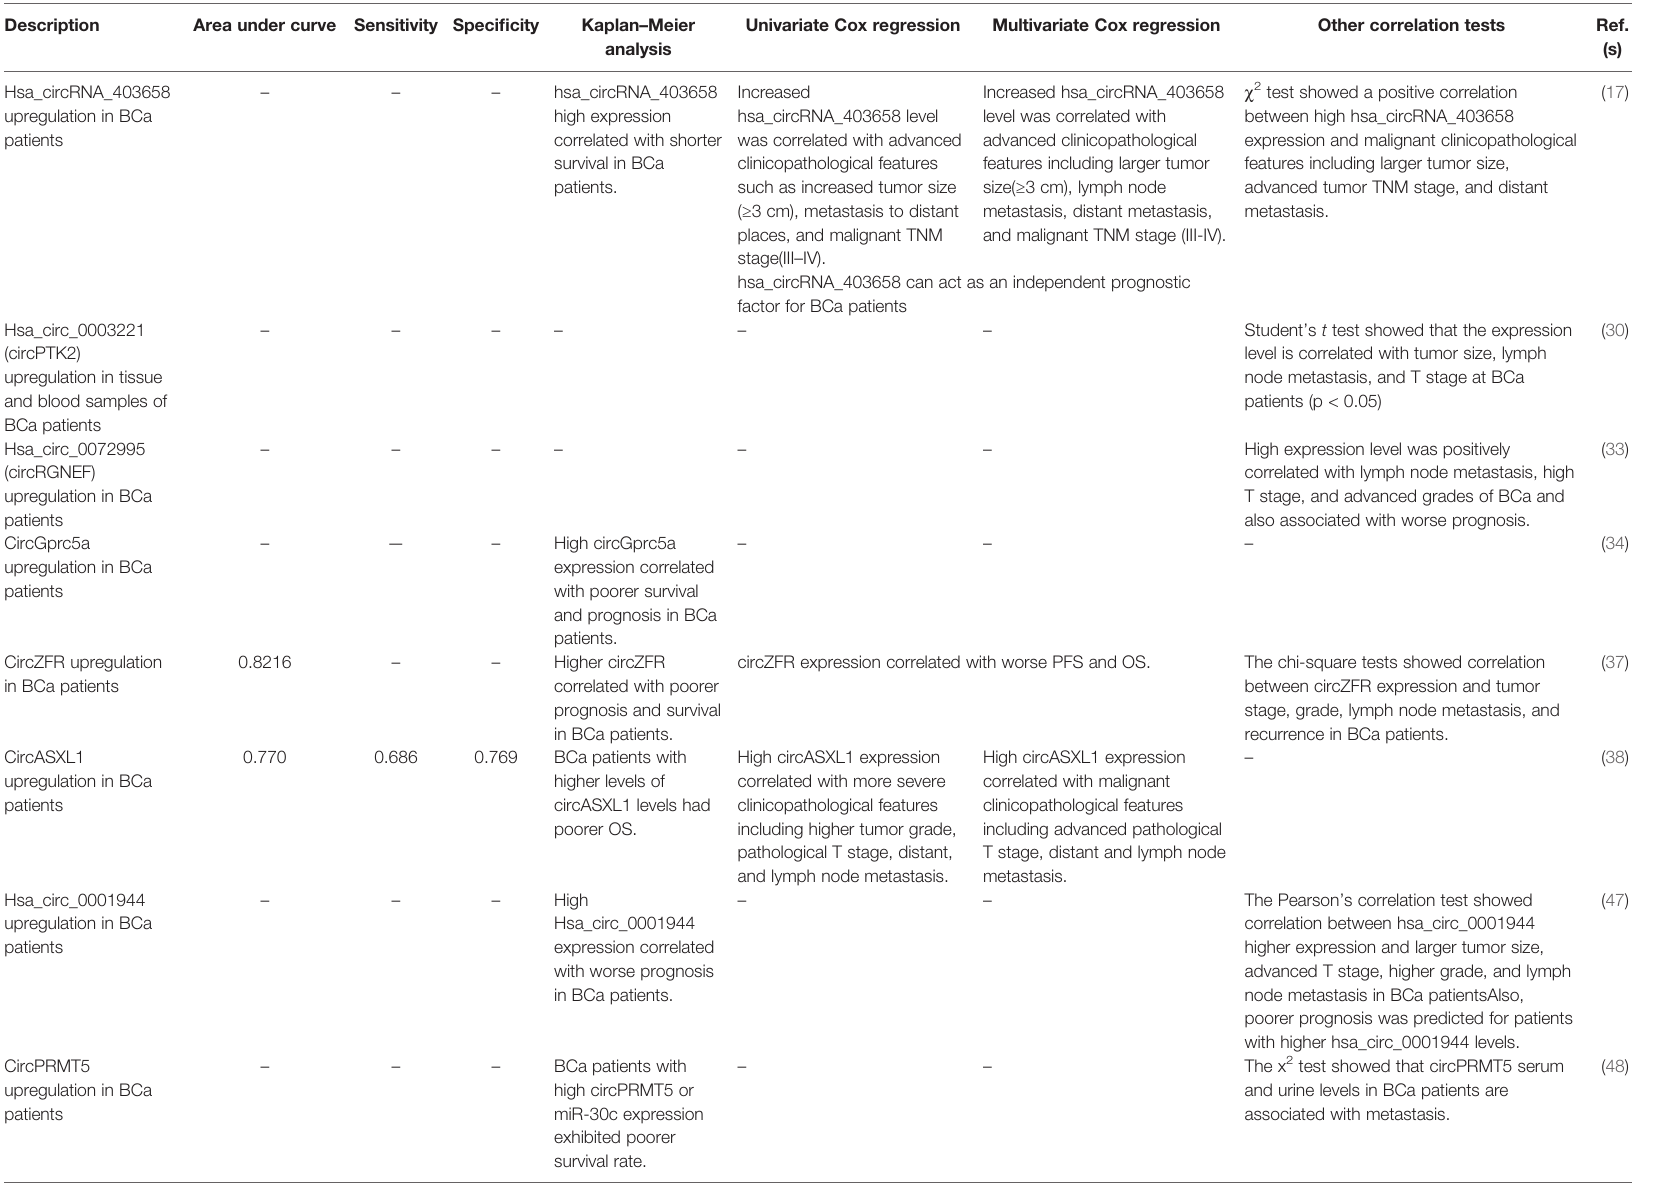
TABLE 3 | An overview to the diagnostic and prognostic values of dysregulated circRNAs in